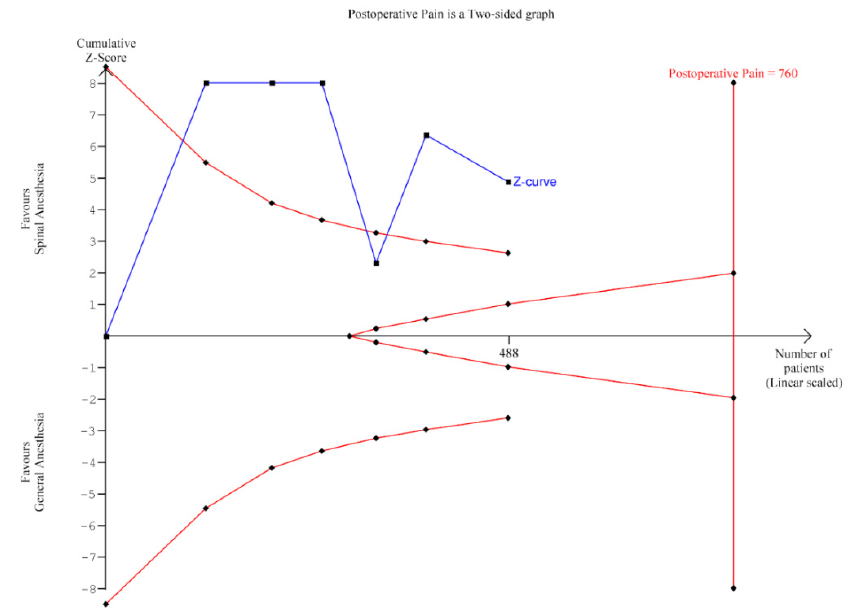
Figure 4. Trial Sequential Analysis of postoperative pain.